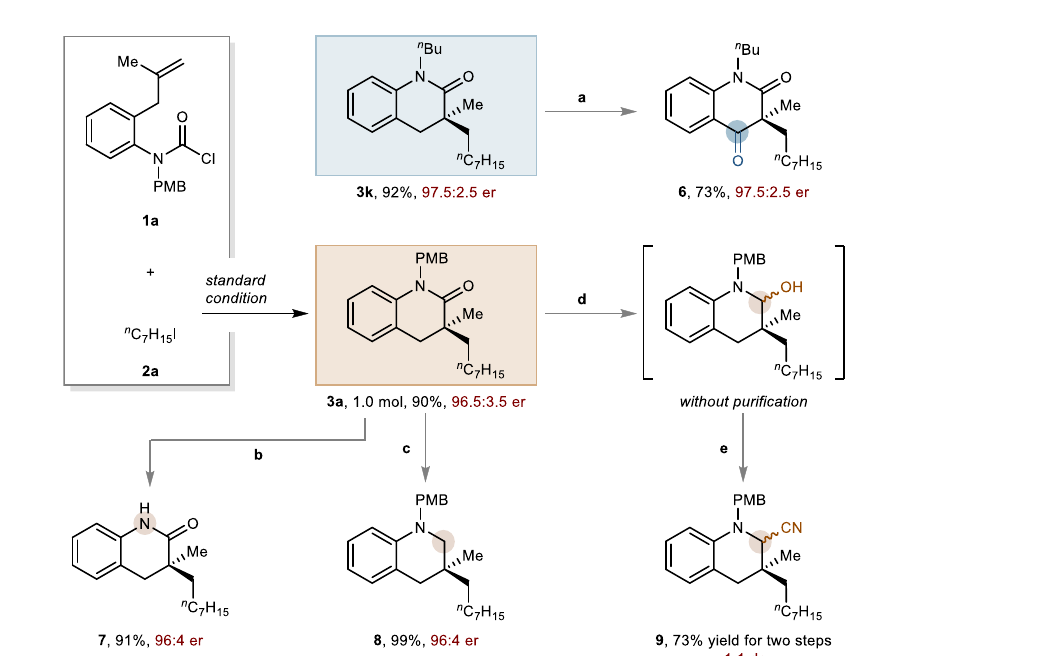
Fig. 5 | Investigation of none aromatic ring tethered carbamoyl chloride. a Optimization of the reaction conditions of none aromatic ring tethered carba- moylchloride.Thereactionwasperformedwithcarbamoylchloride 4a (1.0eq.), 2a (3.0 eq.), Ni(ClO 4 ) 2 (cid:129) 6H 2 O (15mol%), Ligand (18mol%), Mn (4.0 eq.), LiBr (1.0 eq.),